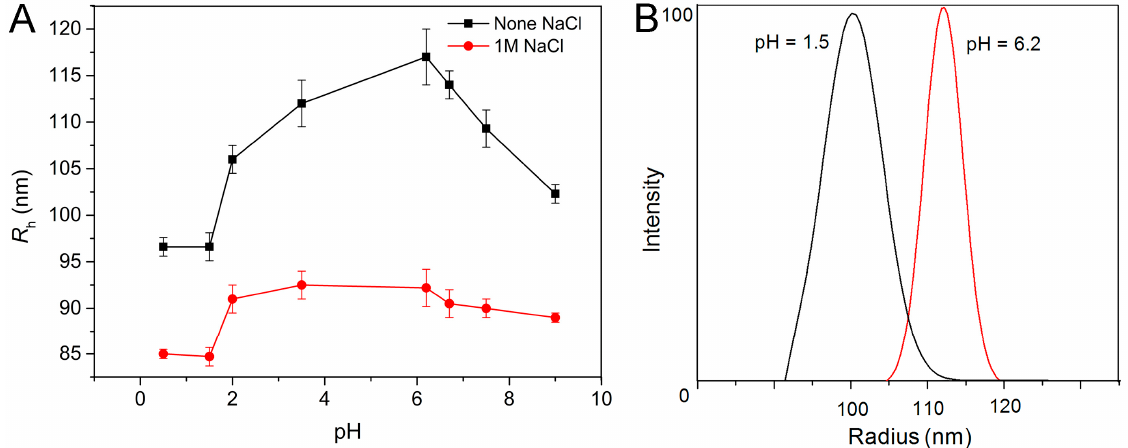
Figure 6. Hydrodynamic radius ( R h ) ( A ) and size distributions ( B ) of PE 607 - b -PLL 275 in water meas- ured by DLS at different pH values.